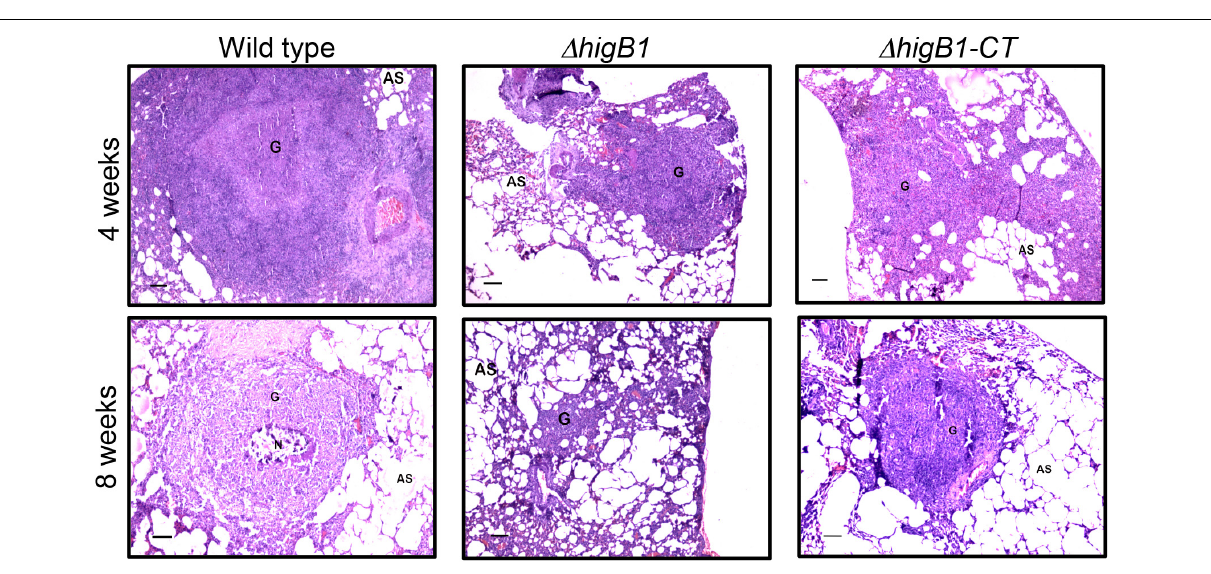
reduced by 9.67-fold in the mutant strain ( Table 1 ). Also, the transcript levels of higA 1 were reduced by 2.18-fold in the mutant strain ( Table 1 ). The transcript levels of Rv1957 did not show any significant change in the mutant strain. The transcript levels of higB 1 were increased by ∼ 5.32-fold in complemented strain